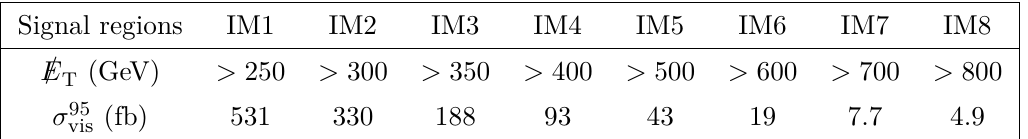
Table 1 . Signal regions in the ATLAS monojet + /E observed 95% C.L. upper limit on the visible cross section σ vis .